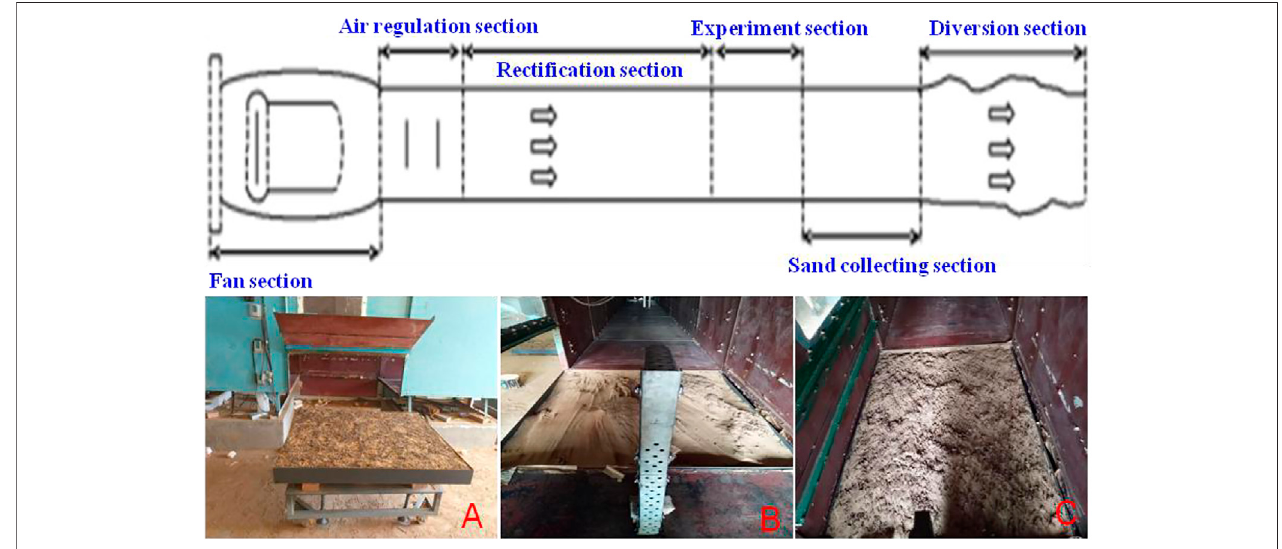
FIGURE2| Schematicdiagramoftheexperimentwindtunnelstructure andentity: (A) experimentslot; (B) sandcollection; (C) statusafter simulatedwinderosion.